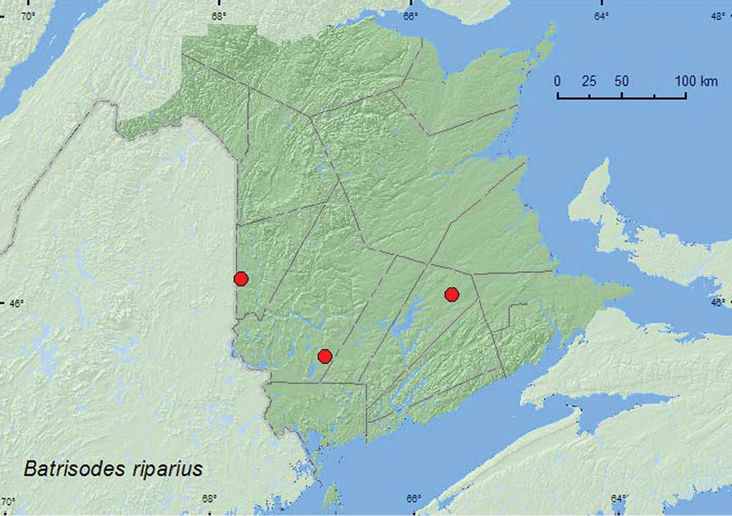
Collection localities in New Brunswick, Canada of Batrisodes frontalis.